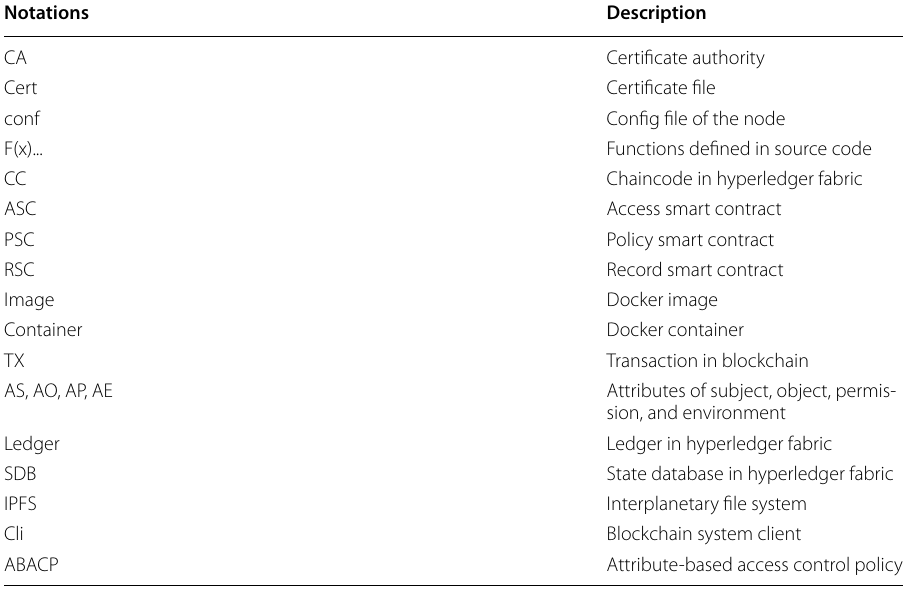
Table 1 The summary of acronyms and definitions Notations